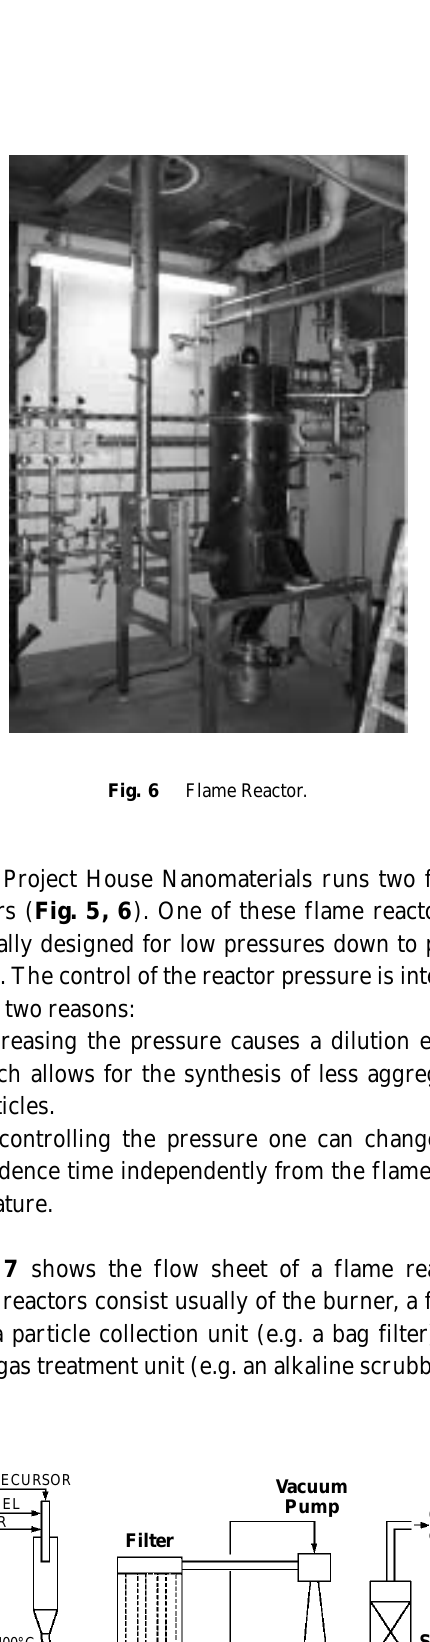
Flow sheet of a flame